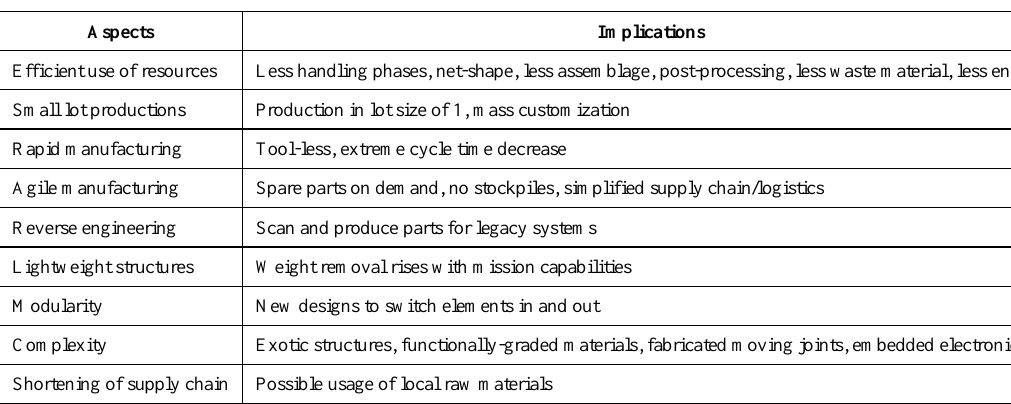
Table 2. Benefits of 3D printing